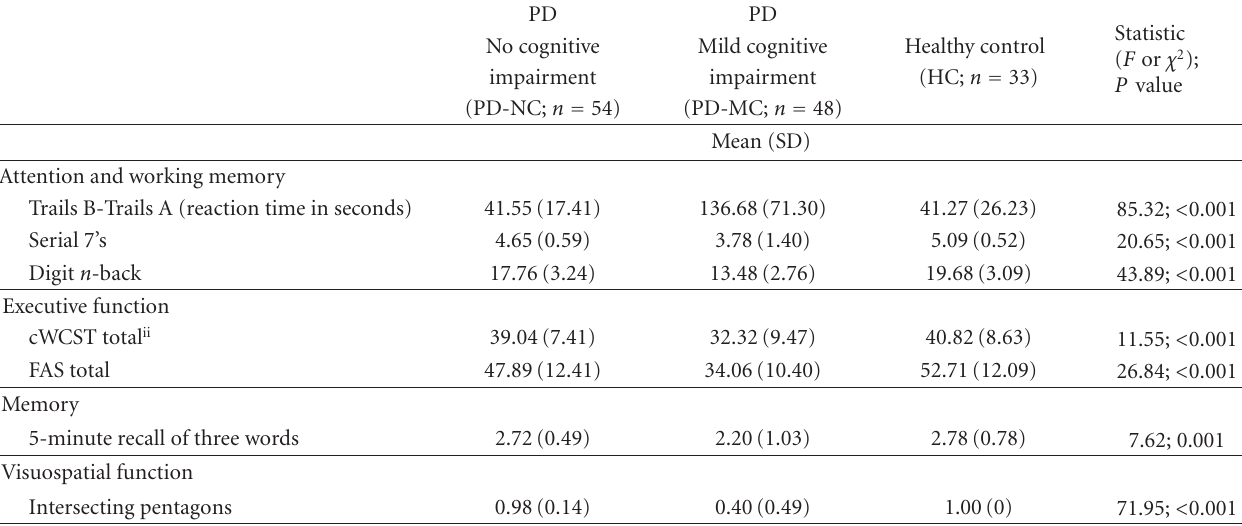
Table 3: Neuropsychological test scores for the PD groups without cognitive impairment and with mild cognitive impairment, and the healthy control